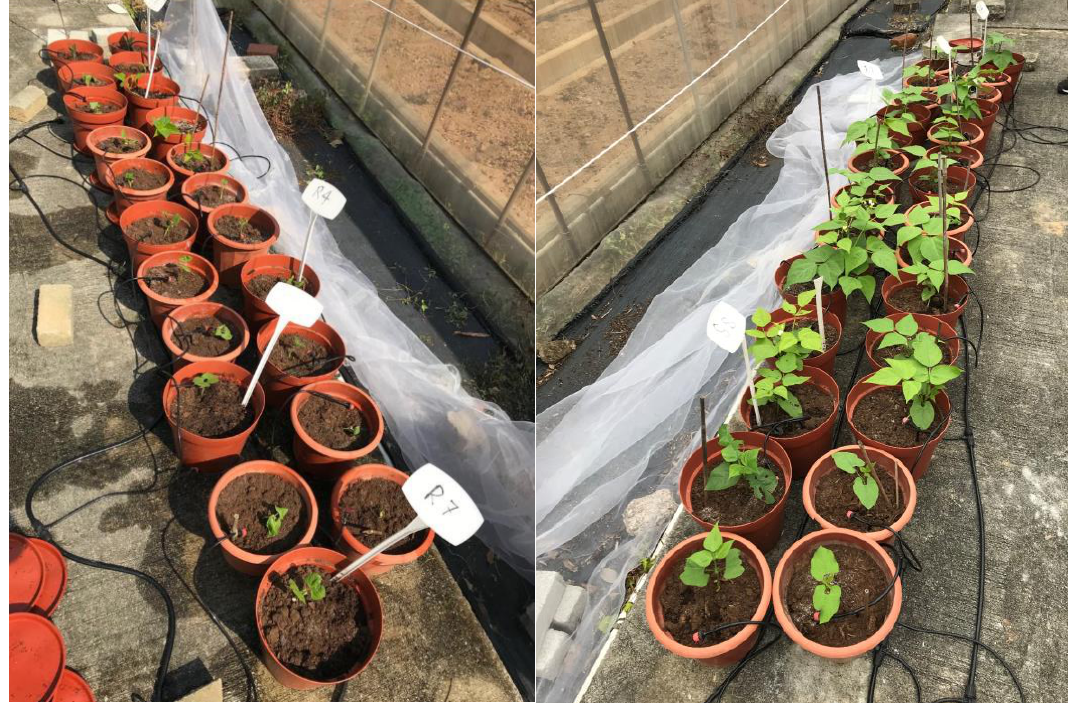
Figure A2. Setup of the 24 pots of Phaseolus vulgaris . The resistant and sensitive genotype pots are placed randomly.